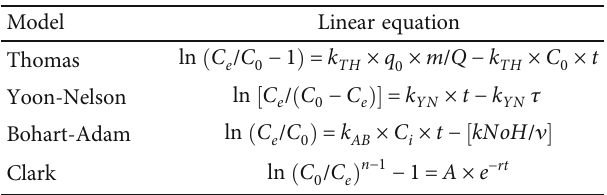
Figure 22: (a) Breakthrough curves at di ff erent fl ow rates ( beddepth = 10cm , CV dyeconc : = 25mg/L ). (b) Breakthrough curves at di ff erent CV concentrations ( flow rate = 0 : 5 mL/min , bed depth = 10 cm . (c) Breakthrough curves for variation in bed depths ( flow rate = 0 : 5mL/min , CVconc : = 25mg/L ). Table 10: Linear equations for breakthrough